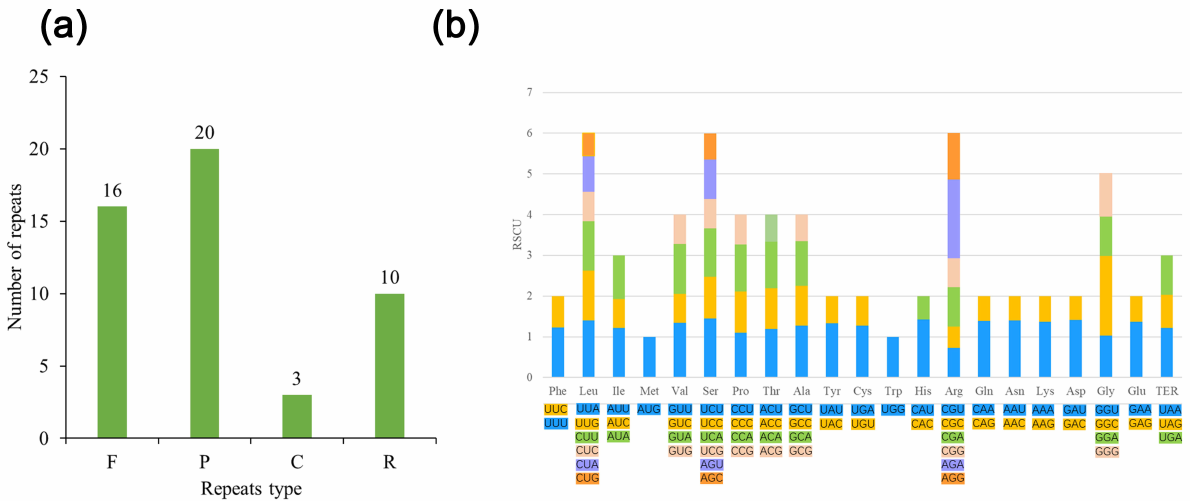
Figure 2. ( a ) Interspersed repeats in L. bulbifera , classified by type and frequency (F = forward, P = palindromic, R = reverse and C = complement). ( b ) The 20 amino acids and stop codon of coding genes of the L. bulbifera chloroplast genome. The color of the histogram corresponds to the color of codons. The codon count of the L . bulbifera genome indicated a total of 44,746 codons in protein- coding genes, encoding 20 amino acids (excluding stop codons). Among them Leu